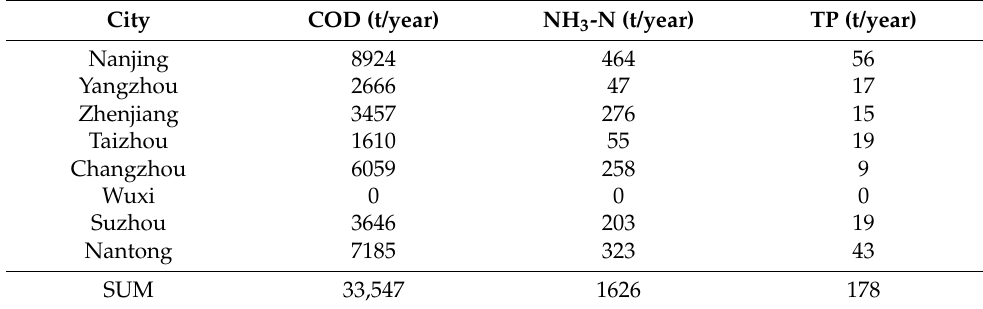
Table 1. Emissions of pollutants from industrial enterprises and sewage treatment